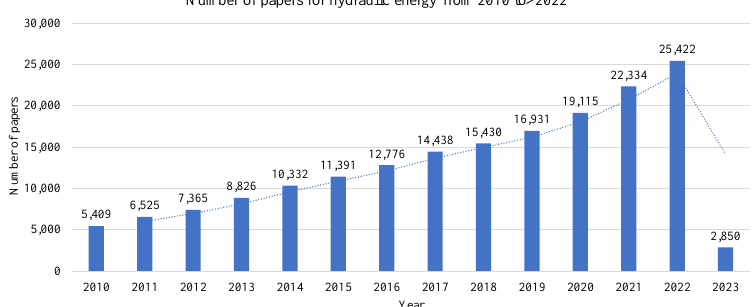
Figure 9. Development of research in the field of hydraulic energy (2010–2022). The dotted line represents the moving average of the published